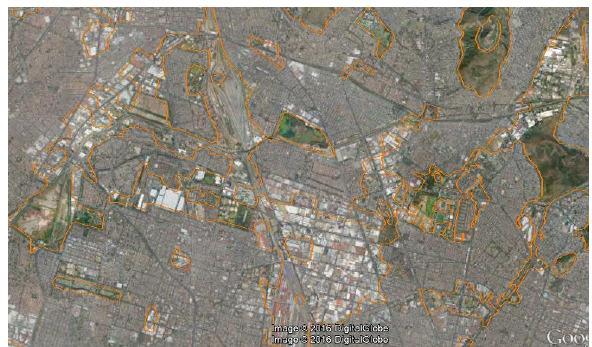
Figure 19. Evaluation of a part of area (3) by Google Earth (with images ©